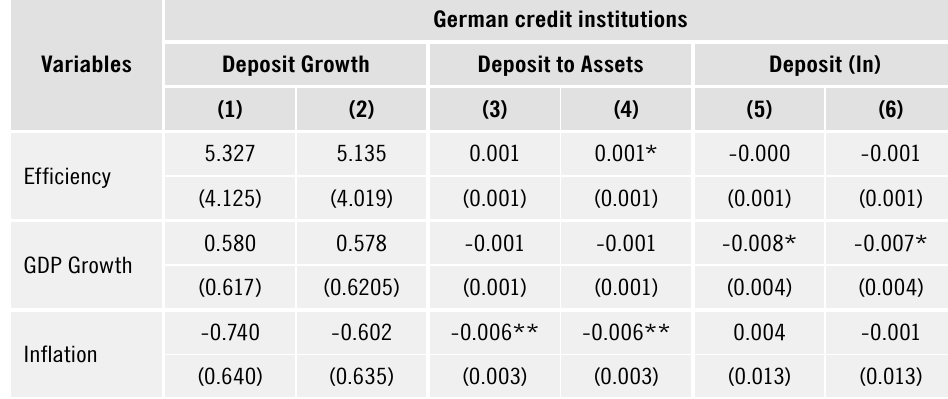
Table 12. Data presenting estimates based on GLS regressions with a random effect on German credit institutions in 2005-2015. Data have been sourced from unconsolidated financial statements. Institution-specific characteristics appear as one-year lagged variables in all specifications. The bank levy (BL) is represented by a dummy variable indicating 1 for all years the levy applies to, and zero for all remaining years. Robust standard errors that control for clustering at the bank level are reported in